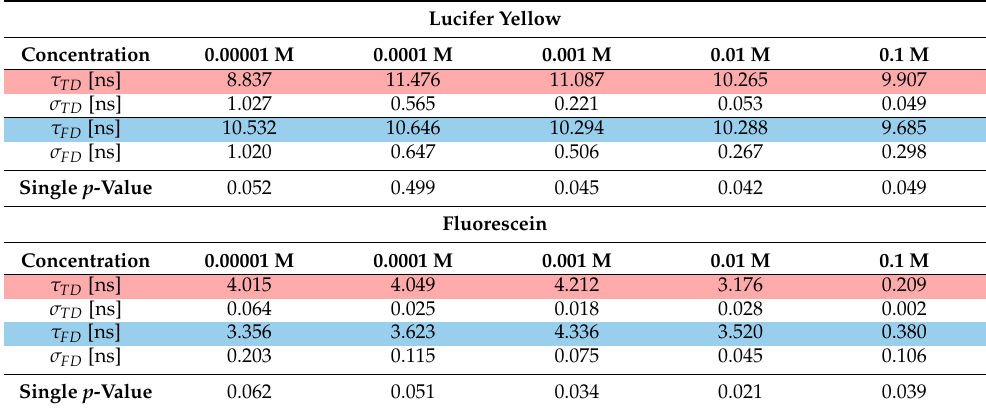
Table 3. TD and FD fluorescence lifetimes and p -values obtained for the concentration series for lucifer yellow and fluorescein.